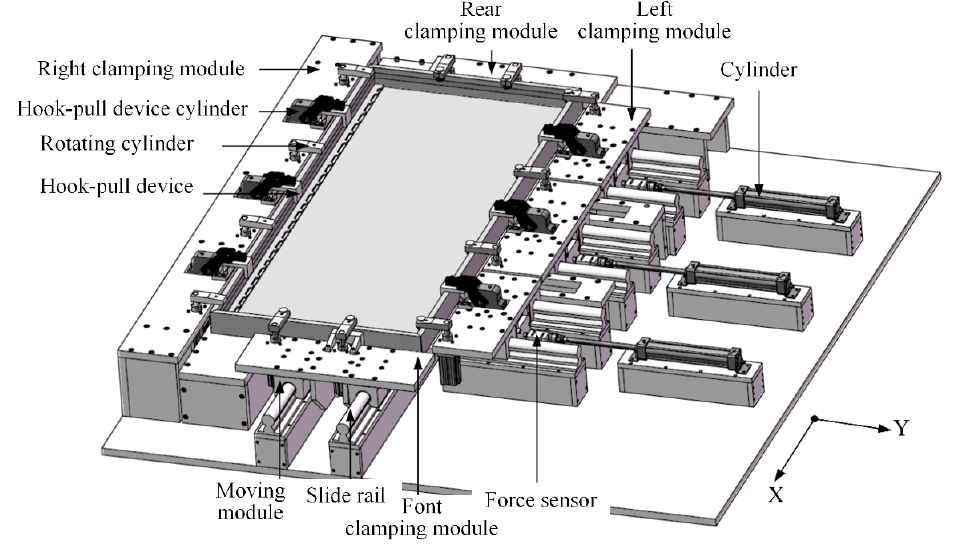
Figure 2. Clamping Figure 2. Clamping modules. Figure 2. Clamping modules.